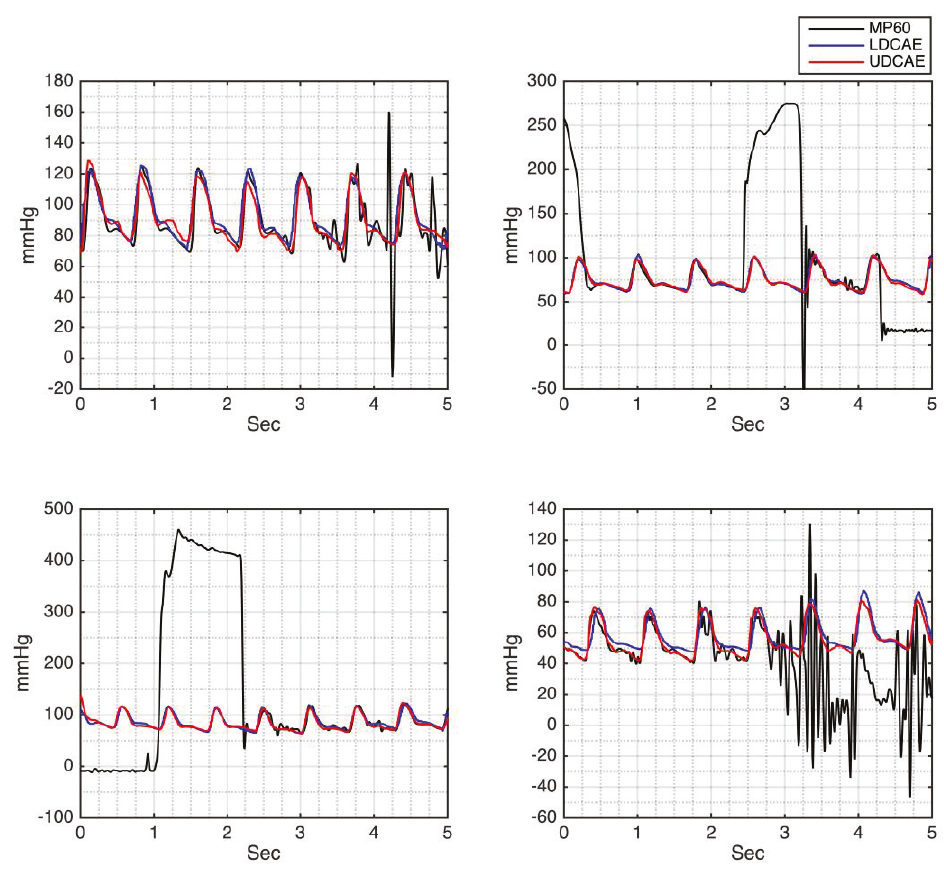
Figure 5. The comparison of the noisy MP60 ABP signal and the generated ABP signal by the LDCAE and UDCAE models. Table 1. The Pearson’s Linear Correlation Coe ffi cient Evaluation of LDCAE and UDCAE Models from the Cross-Validation (CV) Method. Note: bold value is the best single CV